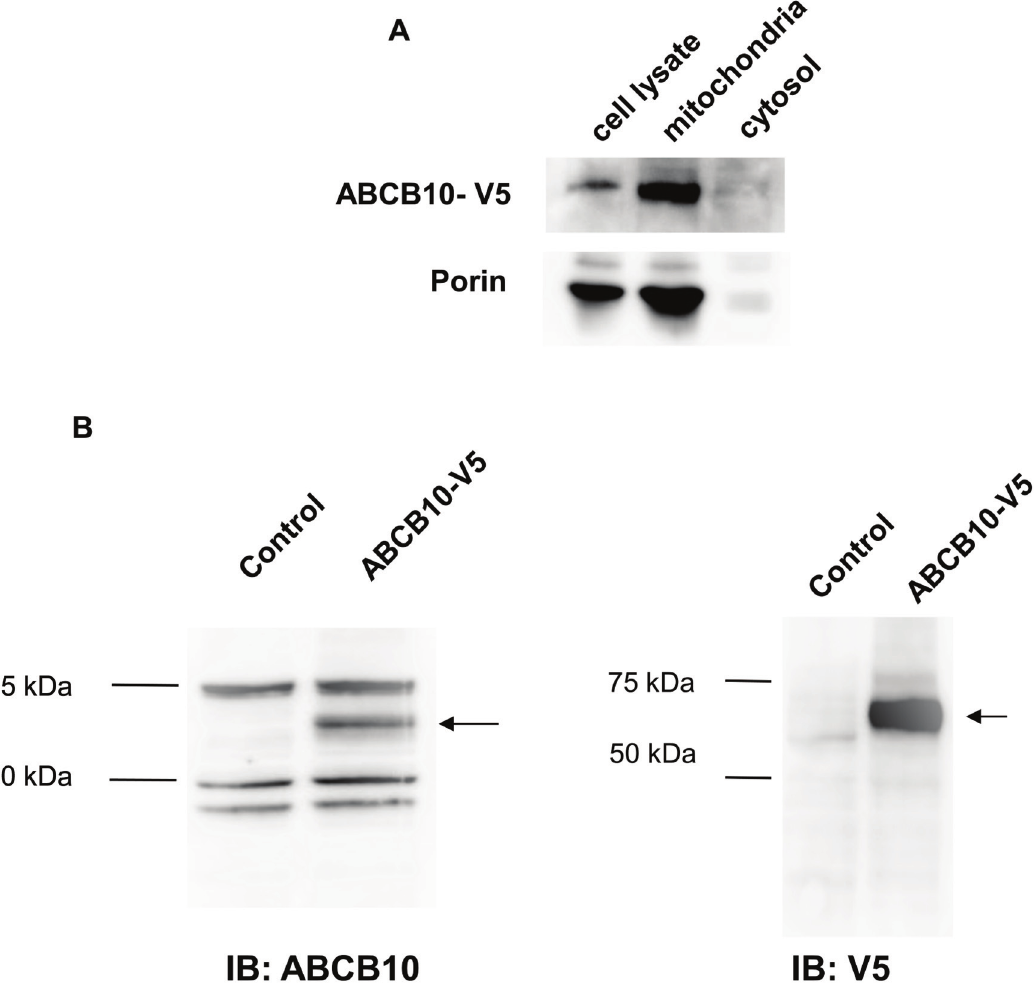
Fig 1. ABCB10-V5 expression and detection in intact mitochondria and SMPs. A) Representative Western blot analysis of over-expressed murine ABCB10-V5 in HEK293 cells after loading 20 ug of protein from total cell lysates, isolated mitochondria or cytosol in a reducing SDS-PAGE gel. ABCB10 (aprox. 65kD) was detected using anti-V5 antibody (1:5000). Detection of mitochondrial outer-membrane protein porin was used as a control for mitochondrial protein content. B) ABCB10-V5 expression in sub-mitochondrial particles (SMPs) obtained from isolated mitochondria from HEK293 cells transfected with empty vector (Control) or with ABCB10-V5 encoding construct. ABCB10 was detected by Western blot using anti-ABCB10 polyclonal antibody (1:2000, showing 3 unspecific bands) (left) and anti-V5 (1:5000) (right) antibody (shown by